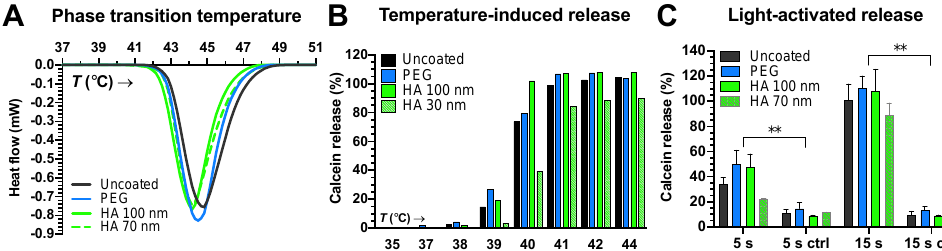
Figure 1. ( A ) Calorimetric analysis of liposomes. Heat flow as a function of temperature ( T ) is shown. ( B ) Calcein release from liposomes at different temperatures. ( C ) Light-activated content release from liposomes after 5 s or 15 s exposures (800 nm laser at 3.2 W/cm 2 ) was significant compared to controls (ctrl) absent the light exposure (** p < 0.01).